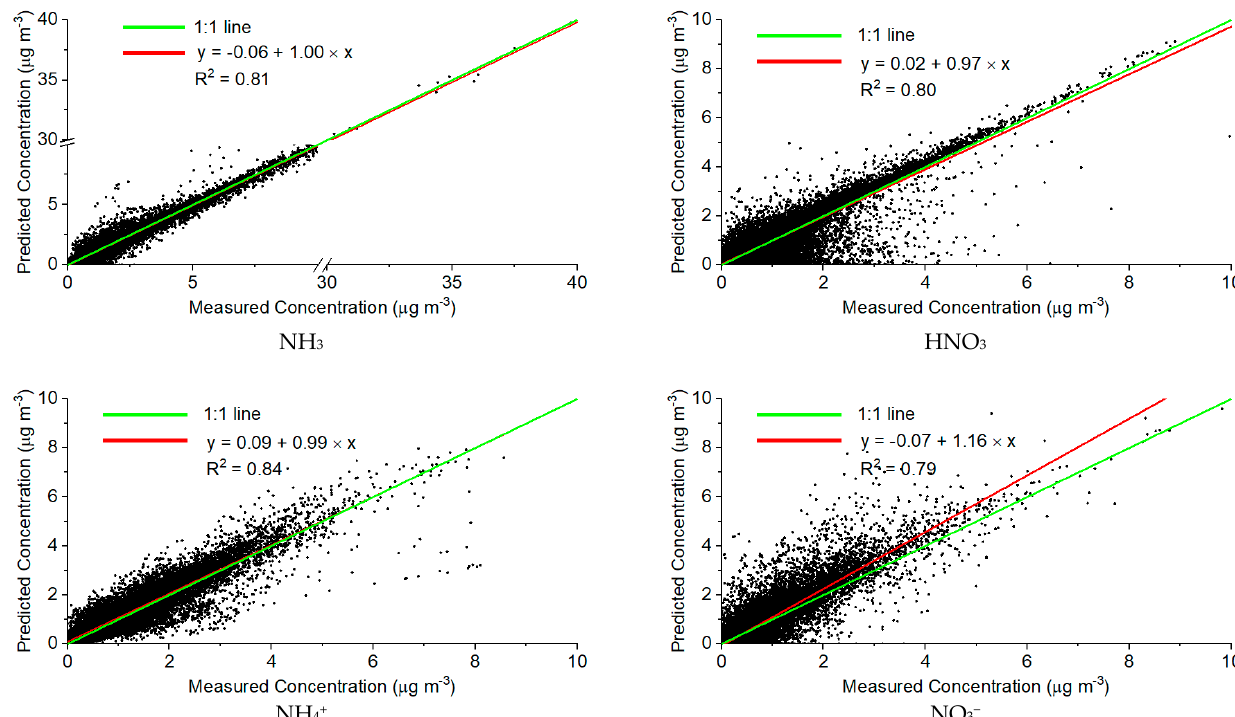
Figure 2. The comparison of prediction and observation using stable setup at the YRK site.